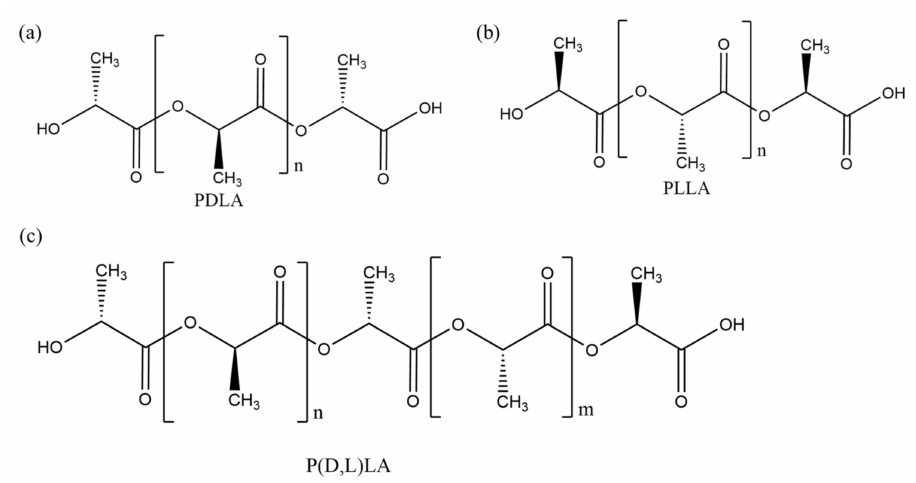
Figure 5. Stereoregular forms of PLA: ( a ) poly-D-lactic acid; ( b ) poly-L-lactic acid; ( c ) copolymer of P(DL)LA with equal proportions L and D subunits.